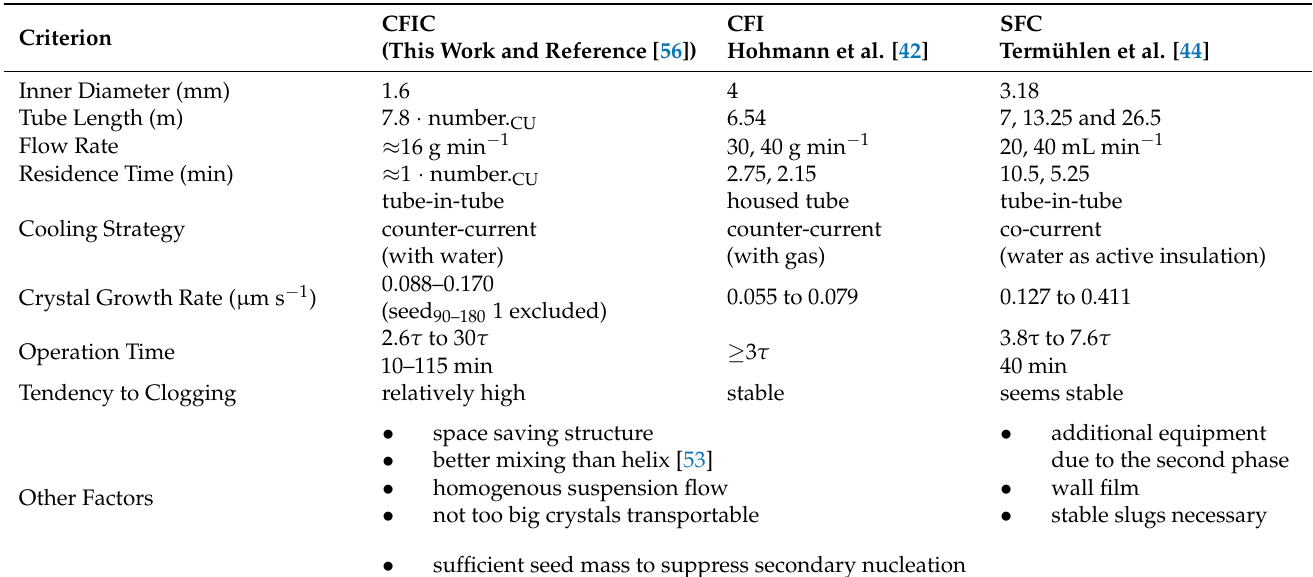
Table 5. Comparison between three coiled crystallizers for crystal growth experiments; all used L -alanine/water as substance system, 1 w.% seed ratio, and FEP as tube